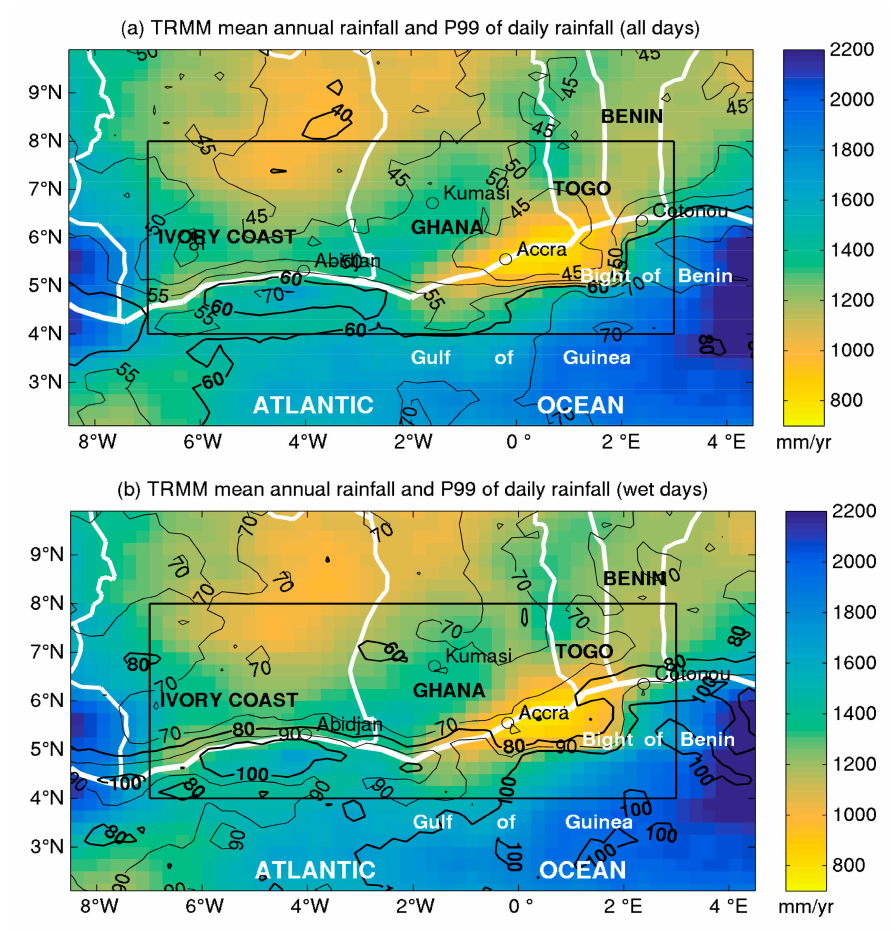
Figure 1. Mean annual rainfall (contours in mm) and 99th percentile of daily rainfall (P99, shadings) from TRMM data. P99 is computed from both wet and dry days ( a ) or from wet days only ( b ). The area over which intense rainfall events are analyzed is